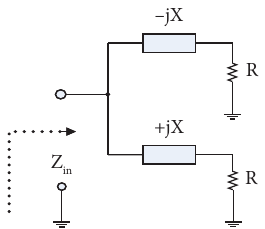
Figure 8: Another structure of the two basic resistance compression networks.